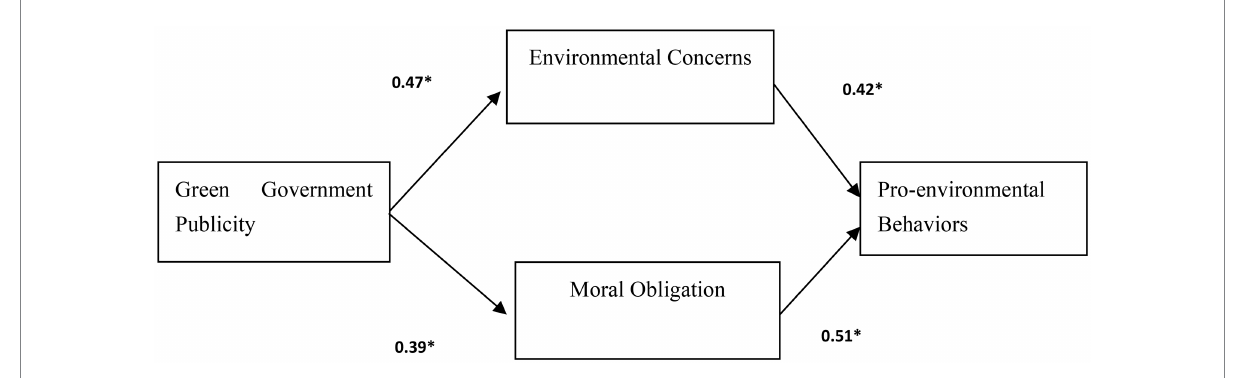
FIGURE 2 Result of the research model. *p < 0.05.